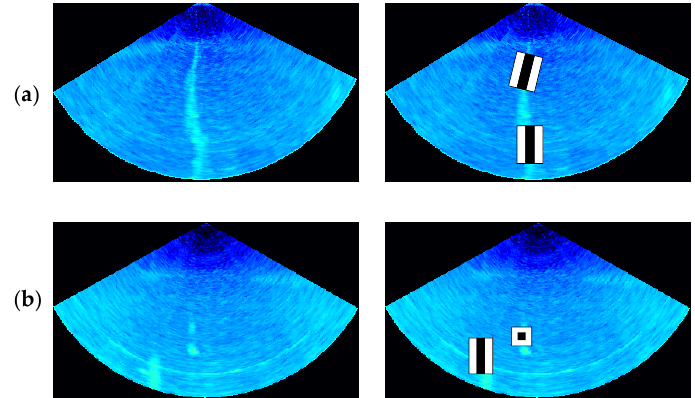
Figure 4. Haar-like feature extraction from an MWC image. ( a ) The line feature is more exact to describe the grey-level changes of the vertical and inclined gas plumes. ( b ) For gas plumes with scatter distributions, the line feature and the center-surround feature can be used for effective description.